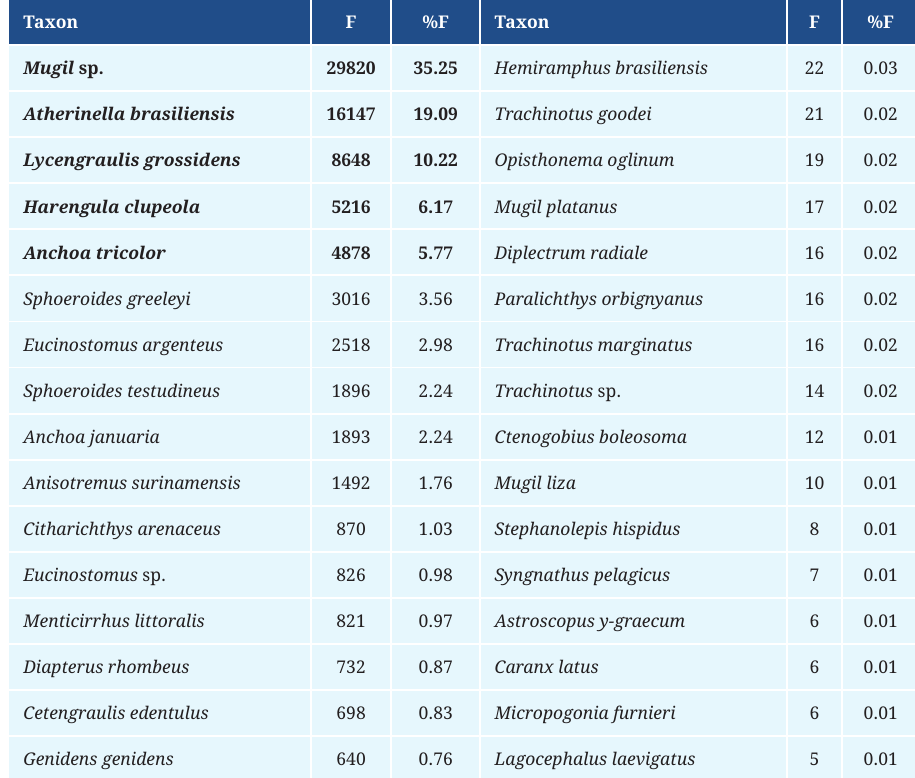
FIGURE 4 | Cumulative species curve calculated with fish samples sampled from May 2000 to April 2001 at eight sites along the estuarine gradient of shallow areas of the north- south axis of the PEC. In gray, the modeled curve based on the Coleman Estimator (Coleman et al. , 1982). Boxplots were generated from mean. Crosses represent